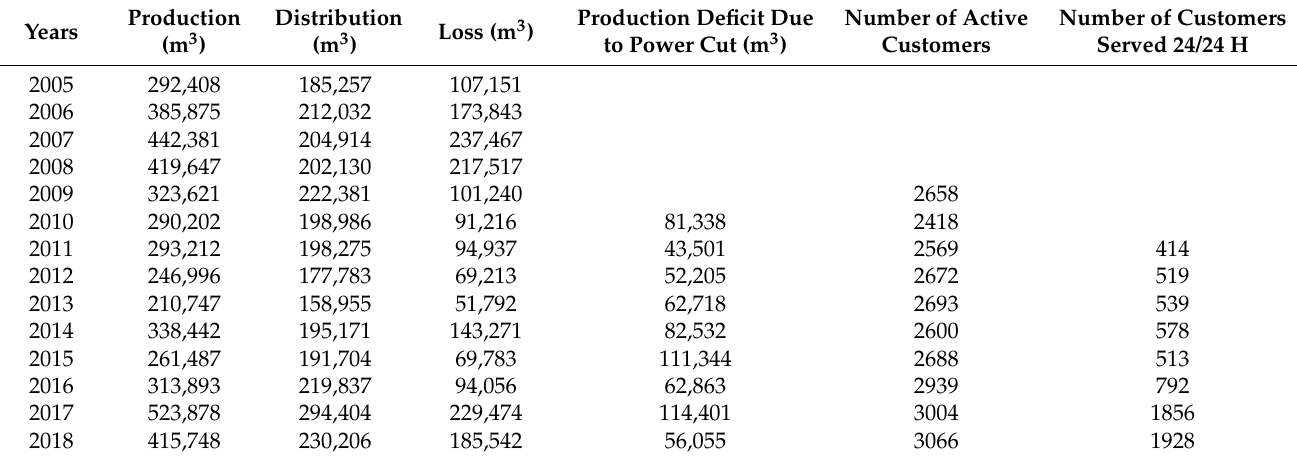
Table 1. Water production and distribution of the CAMWATER network in Bangangt é . Data from ref. [5]. Years